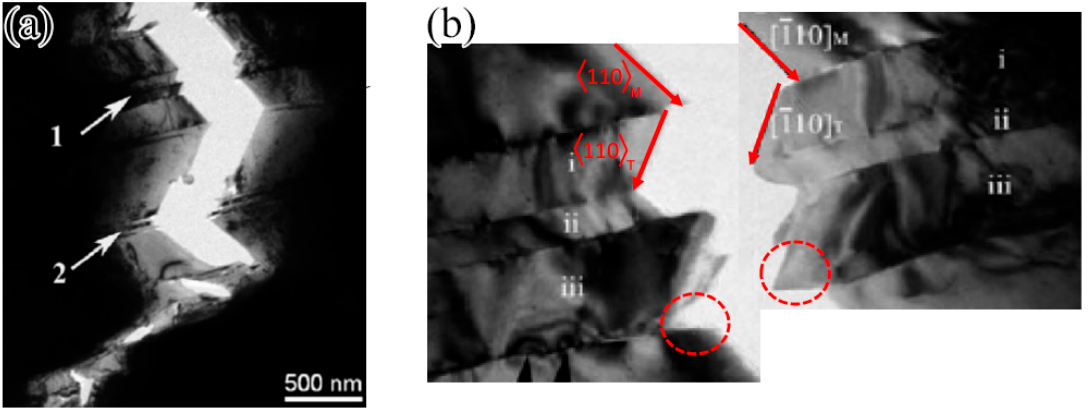
Figure 14. In situ TEM images of crack growth process in a thin foil of NT Cu. ( a ) A zigzag crack formed during tensile loading. ( b ) Magnified images of region 1 in ( a ), circles indicate the short crack edges on TBs. Adapted from [107].